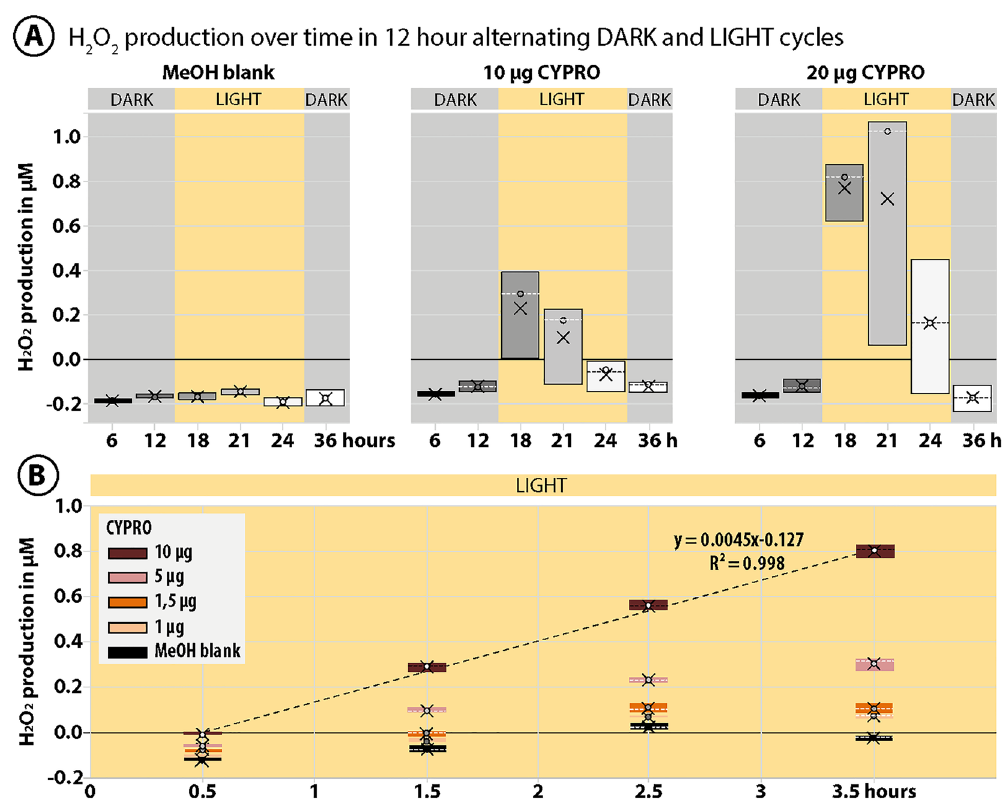
Figure 2. Hydrogen peroxide (H 2 O 2 ) production by cycloprodigiosin (CYPRO) over time in oscillating light regimes. ( A ) Production of H 2 O 2 by photodegradation of CYPRO at 10 and 20 μg in 300 μL filtered artificial seawater (FASW). H 2 O 2 concentrations were monitored for 36 h in 12 h-alternating phases of darkness (grey) and light (yellow). ( B ) Light-dependent linear production of H 2 O 2 by 1, 1.5, 5 and 10 μg CYPRO in 300 μL FASW within the first 3.5 h of exposure to light after darkness. The light driven degradation of CYPRO clearly corresponds with a constant and linear production of H 2 O 2 . Evaporated MeOH without CYPRO served as blanks. In the boxplot, the dashed lines indicate the median, while X represents the mean H2O2 production at each time